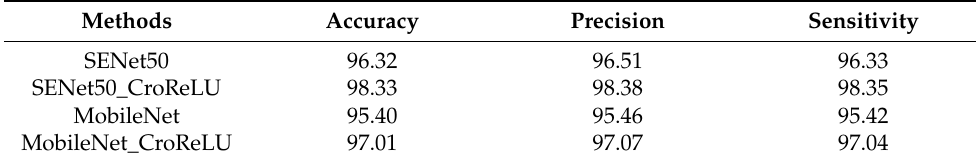
Table 1. Comparison of the accuracy of ReLU and CroReLU for lung cancer disease screening using two types of neural network models on a private dataset